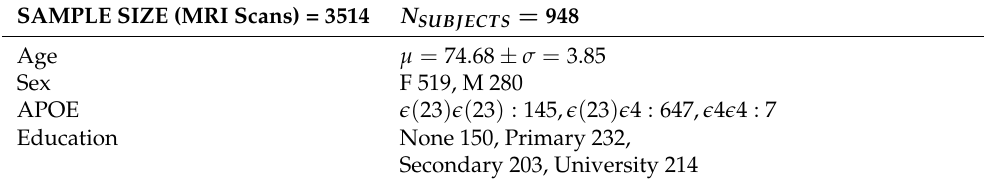
Table 1. The subjects participating in the study had at least one MRI. After anomaly detection, a total of 3514 neuroradiological assessments were analyzed, with the resulting volumetric analysis shown in Table 2. The table shows the description of the demographic and genetic variables included in the study. M: male, F: female, APOE (cid:101) ( 23 ) (cid:101) ( 23 ) : lacking allele (cid:101) 4, (cid:101) ( 23 ) (cid:101) 4 one allele (cid:101) 4 and (cid:101) 4 (cid:101) 4 both alleles (cid:101) 4. Educational attainment level, None: no formal education, Primary: primary education